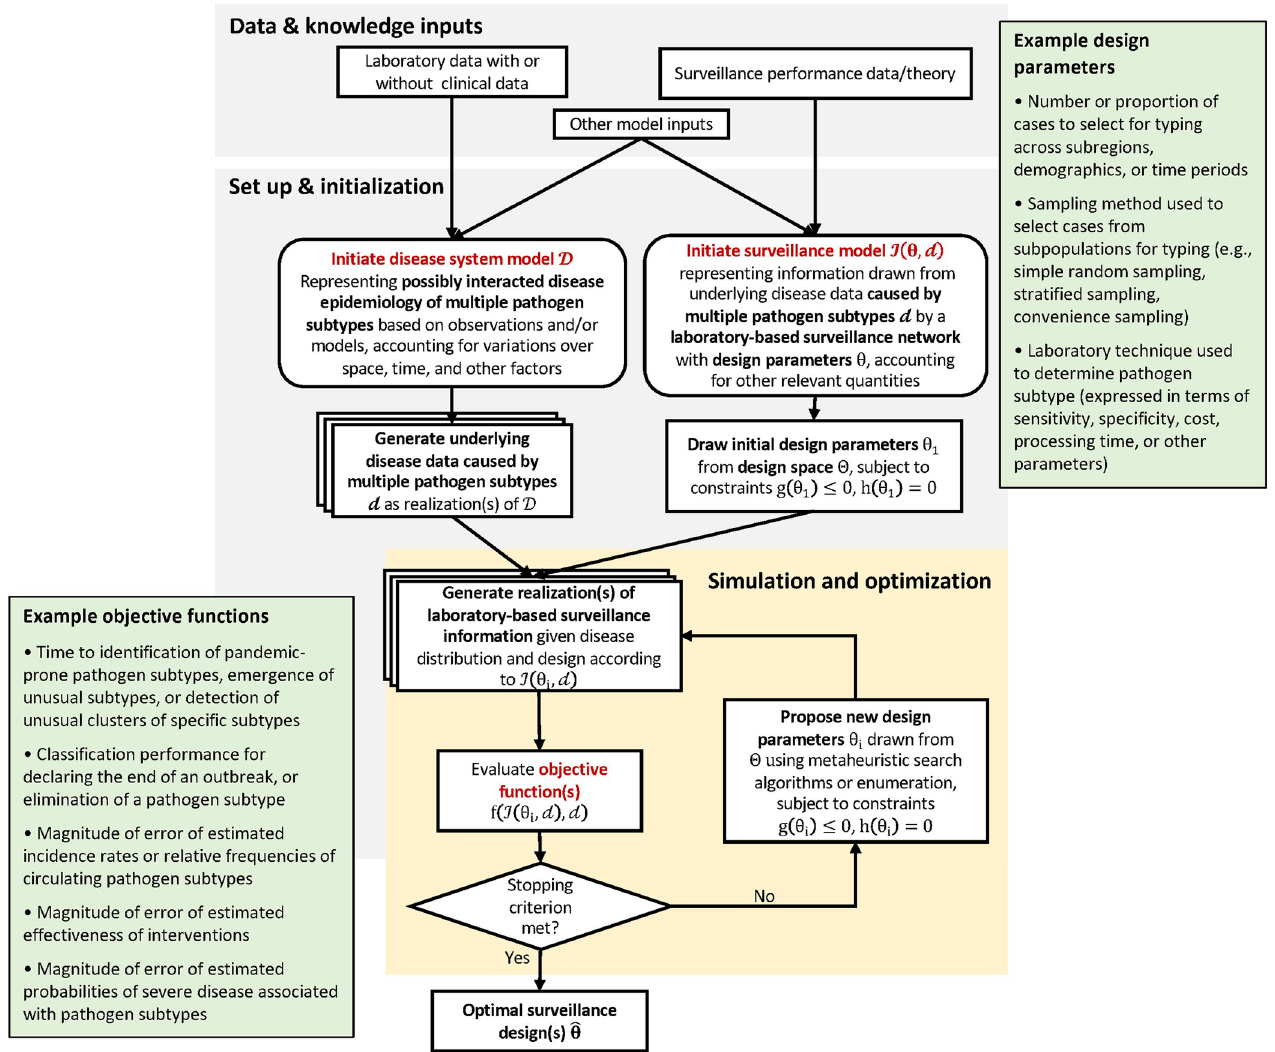
Fig 1. Schematic of the DIOS framework for optimizing surveillance of infections caused by multiple pathogen subtypes, with example design parameters and objective functions presented in green boxes.